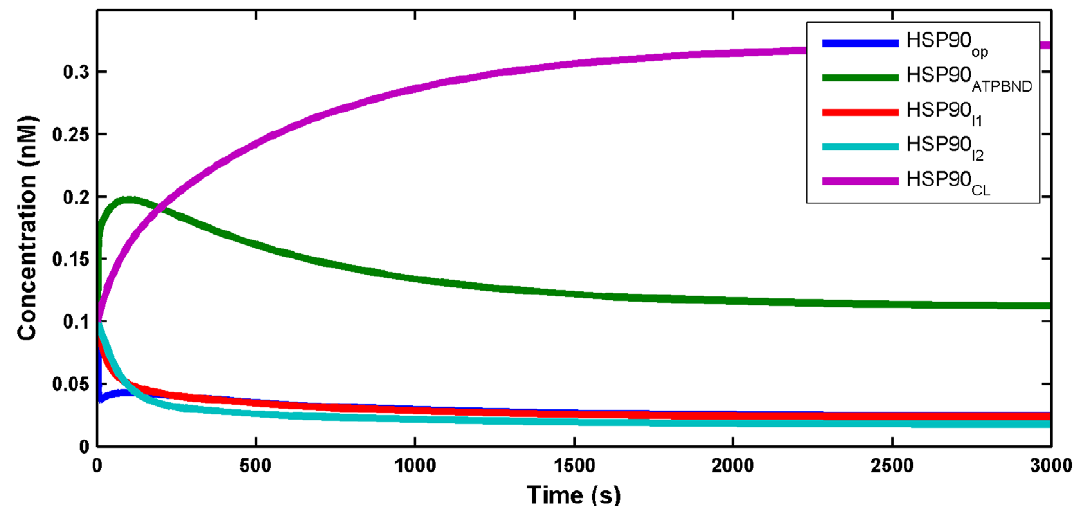
Figure 4. Time course of the various forms of HSP90. Simulated time course of the open, closed, and the intermediate forms of the HSP90 concentrations using the equations described in module 3. The initial concentration chosen for all the dynamical variables was 1 | 10 { 3 nM and they were allowed to evolve to the equilibrium point simulating a relaxation experiment.